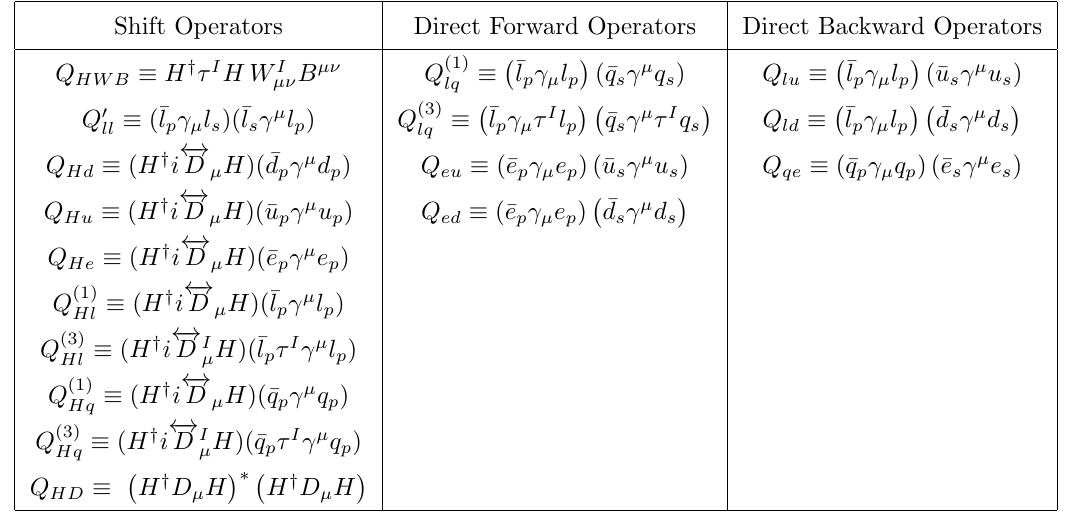
Table 1. Table of operators contributing to dilepton production in the SMEFT, sorted into shift- type operators and direct operators, which are further sorted by angular behavior. Note